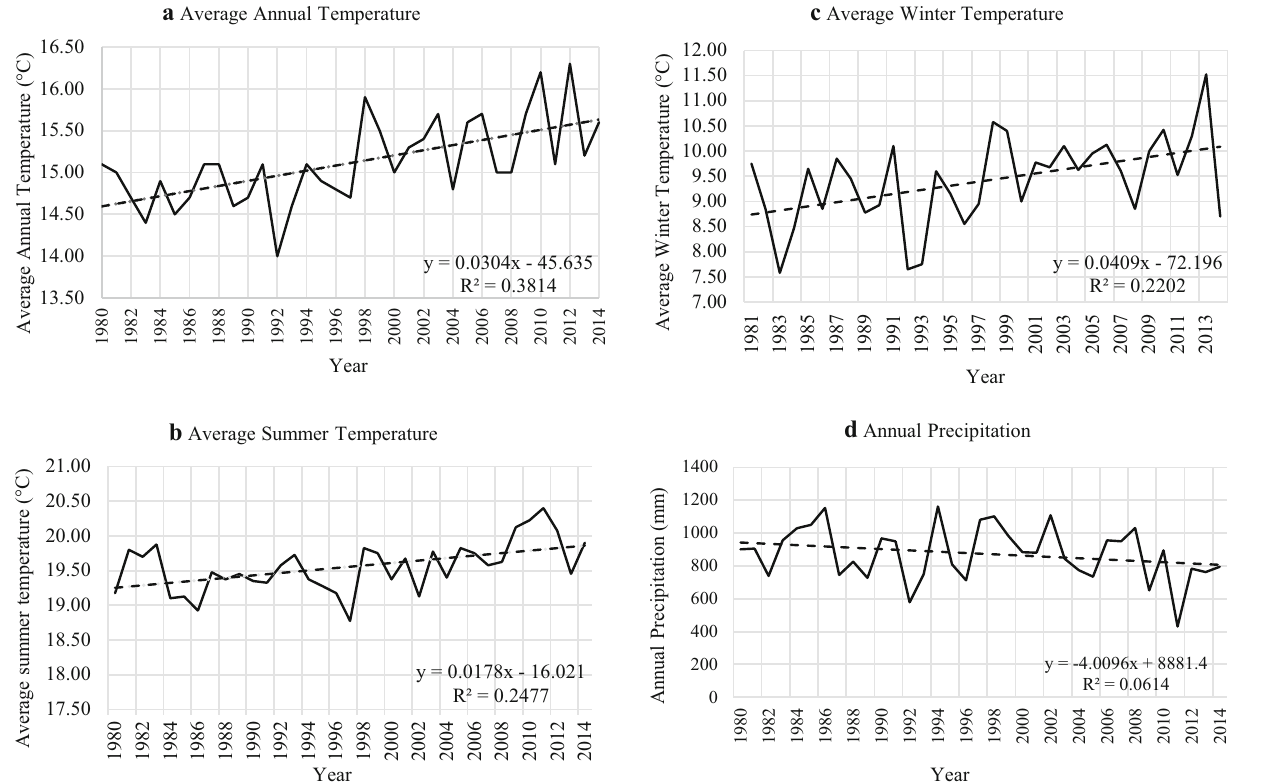
Fig. 3 Average a annual, b summer, and c winter temperatures, and d annual precipitation, for the period 1980–2014 for Luliang